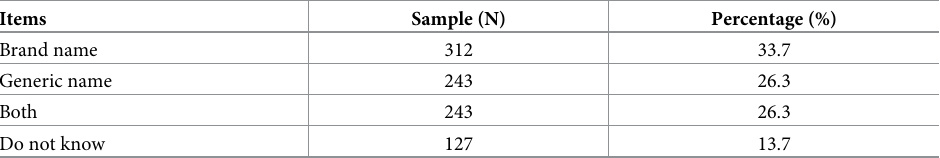
Table 10. Dietary supplement product